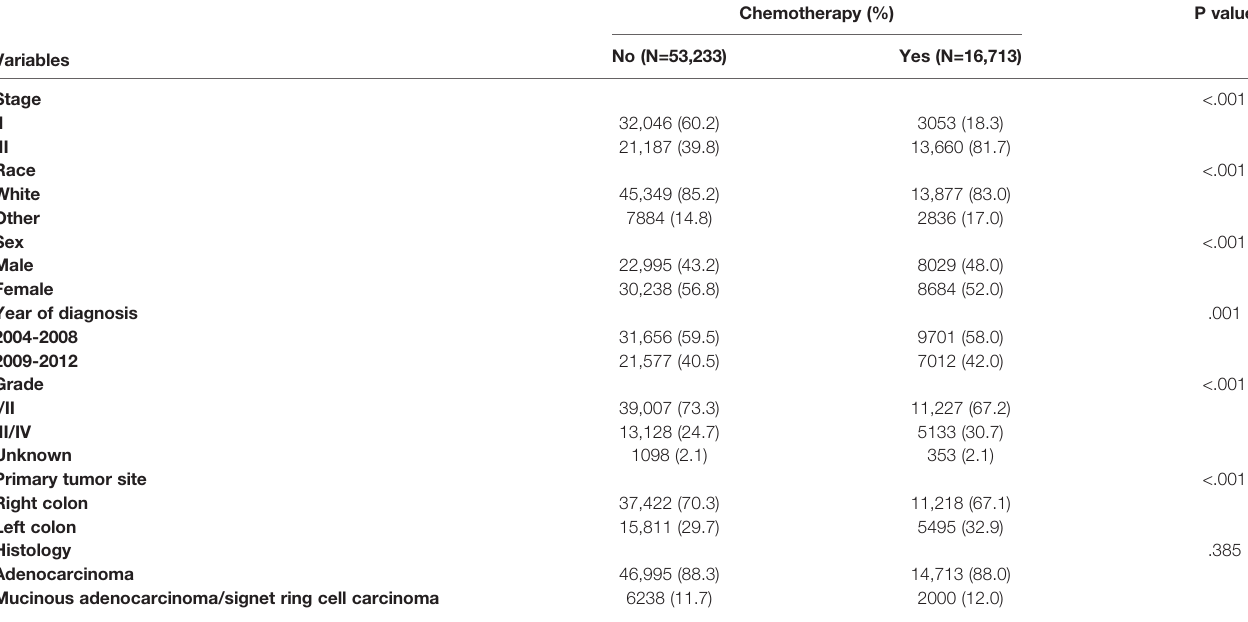
TABLE 1 | Clinicopathological characteristics of colon cancer patients by the receipt of chemotherapy.